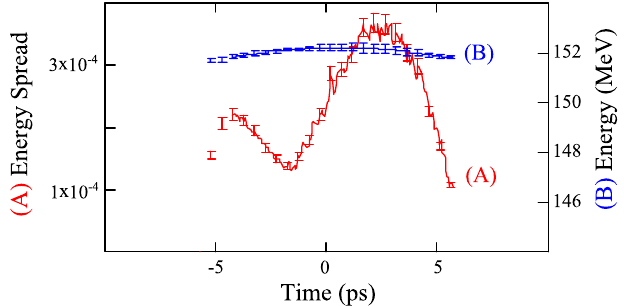
FIG. 6. Beam energy spread (A) and beam energy (B) as a function of time along the bunch. Error bars represent (cid:2) 1 standard deviation on the local energy spread measure. The energy error bars are calculated as (cid:2) 3 standard deviations of the energy measured at the specific longitudinal position. This parameter is related to the instrumental accuracy of the single shot measurement and does not reflect shot to shot energy fluctuations or drifts as indicated in Table I.